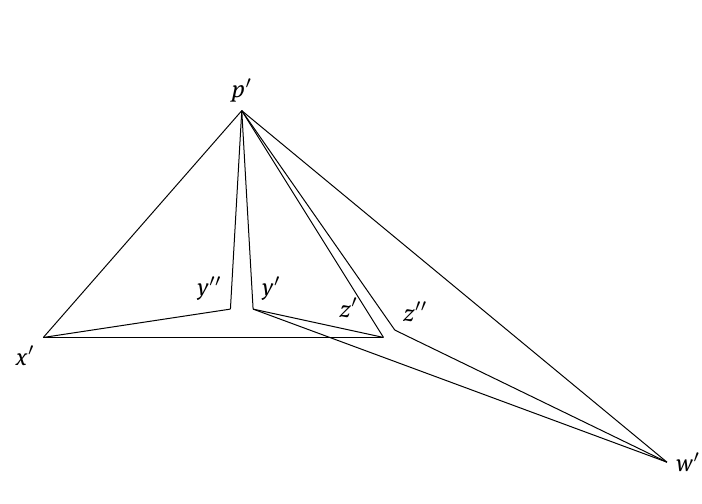
Figure 7.3: The points in R 2 appeared in the proof of Lemma